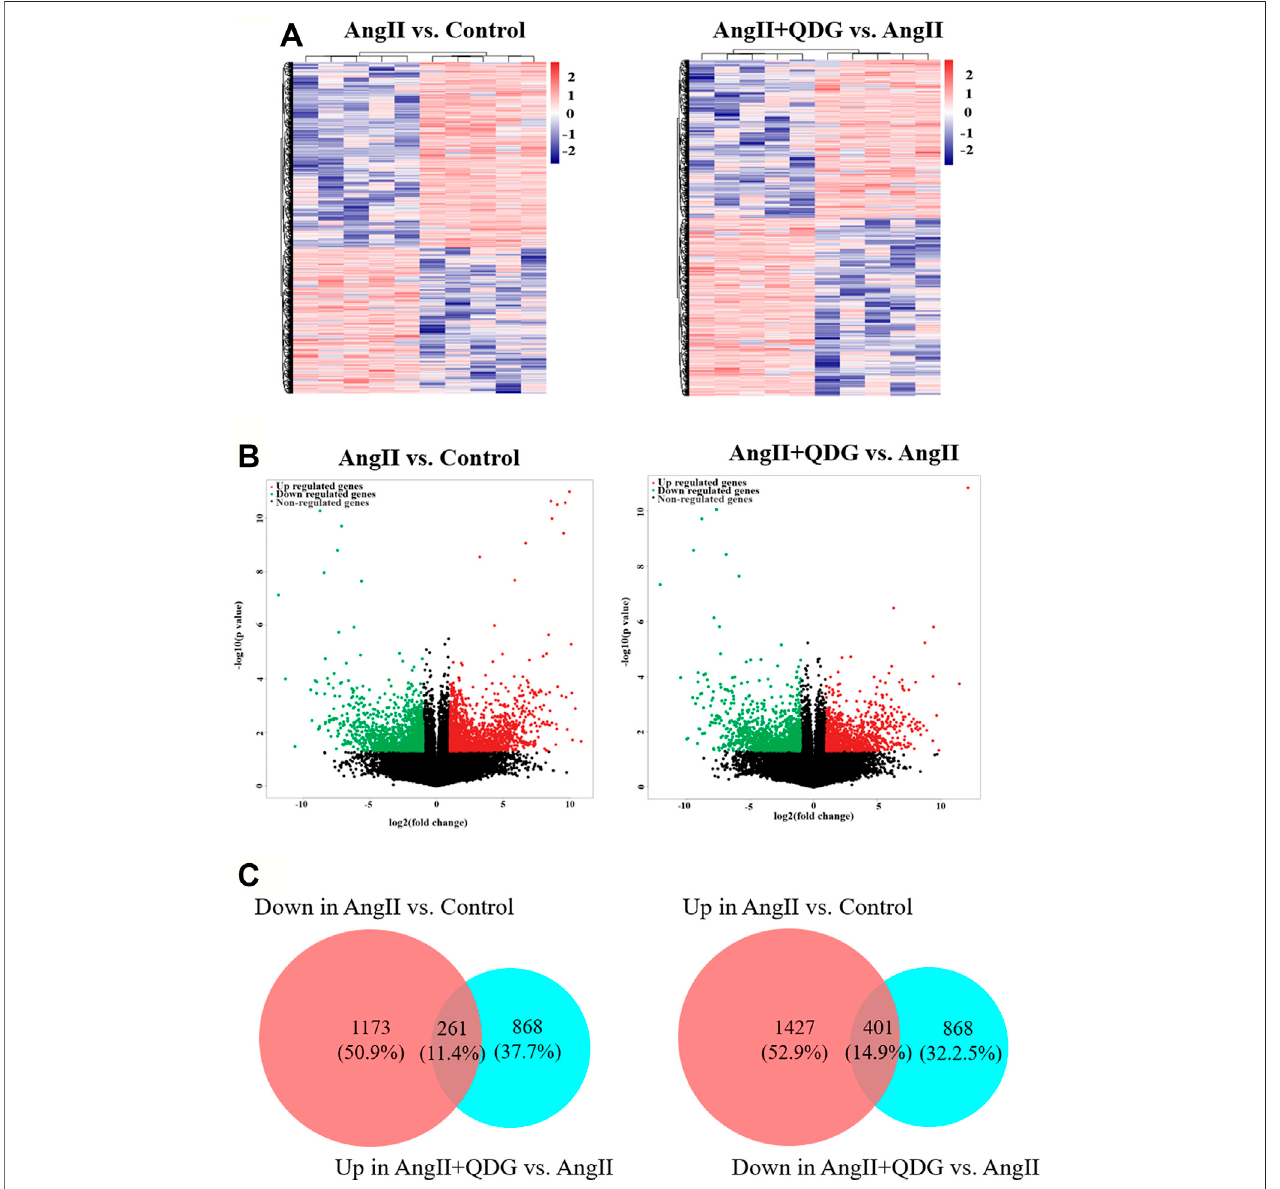
FIGURE2| QDGtreatmentongeneexpressionpro fi lingofrenaltissuesinAngII-infusedmice.RNA-seqwasperformedtodeterminetheDETsinrenaltissuesfrom each group. (A) Hierarchical clustering plots and (B) volcano plots were used to compare gene expression pro fi les (|fold change| ≥ 2, p < 0.05). (C) Integrative analysis wasperformedtoidentifytheintegratedtranscriptsbetweenthetwocomparisons.Theoverlappedareaintheleftpanelrepresentsdecreasedtranscriptnumber(261)in theAngIIgroupbutincreasedintheAngII+QDGgroup.Theoverlappedareaintherightpanelrepresentsincreasedtranscriptnumber(401)intheAngIIgroupbut decreased in the Ang II + QDG